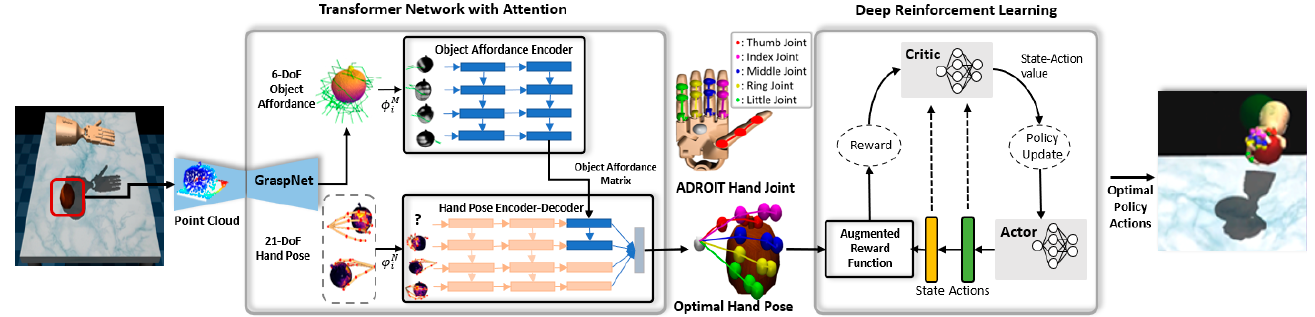
Figure 1. Overview of the proposed T-DRL. The DRL training for object manipulation using the estimated optimal hand pose from the transformer network.